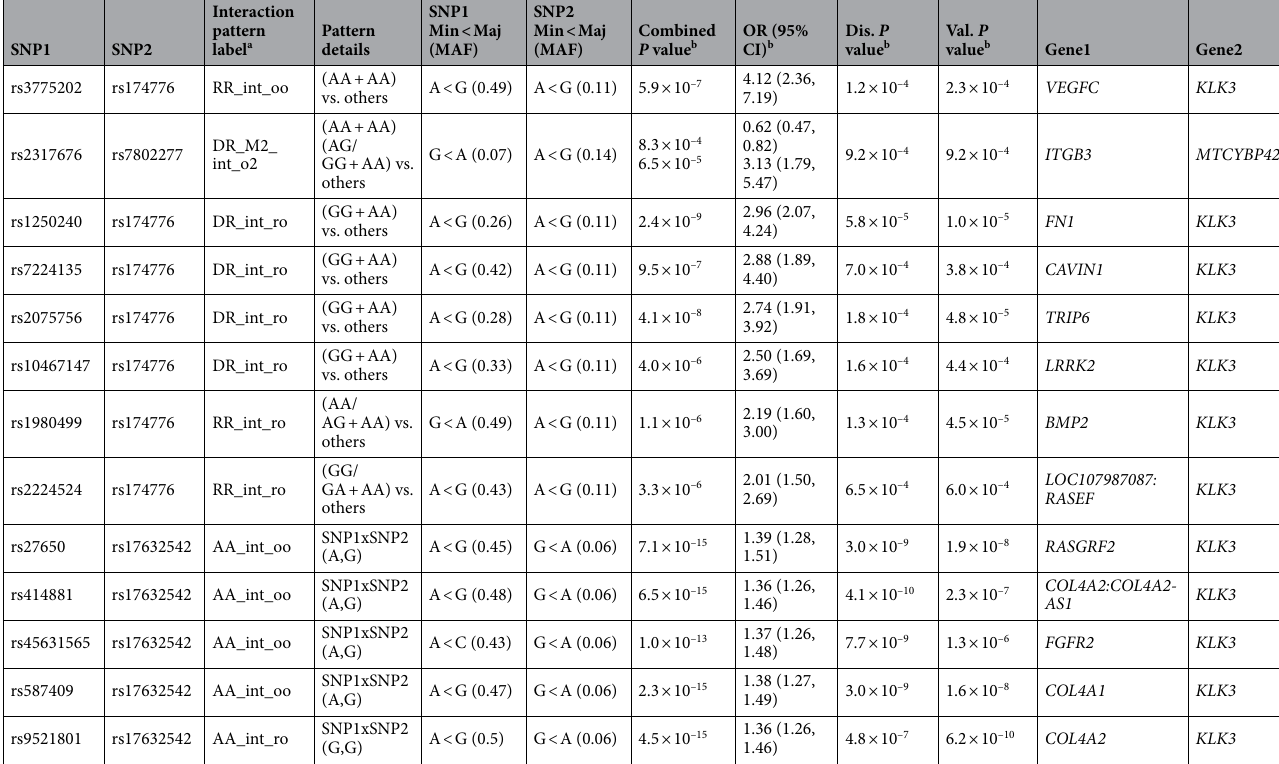
Table 3. SNP interaction pairs with a large effect size associated with prostate cancer aggressiveness. CI confidence interval, Dis discovery set, MAF minor allele frequency, Maj major allele, Min minor allele, OR odds ratio, Val validation set. a SIPI pattern interpretation: The first 2 letters represent inheritance modes of the first SNP (or SNP1) and the 2 nd SNPs (or SNP2); mode (A, additive mode; D, dominant mode; R, recessive mode; “(SNP1 mode)(SNP2 mode)_int_(SNP1 code)(SNP2 code)” is for interaction-only pattern; “M _int_”, interaction plus one main effect of SNP ; SNP code (o, original coding based on the minor allele; r, reverse ϕ coding; o1: original coding for SNP1 (SNP2 with original coding); r2: reverse coding of SNP2 (SNP1 ϕ